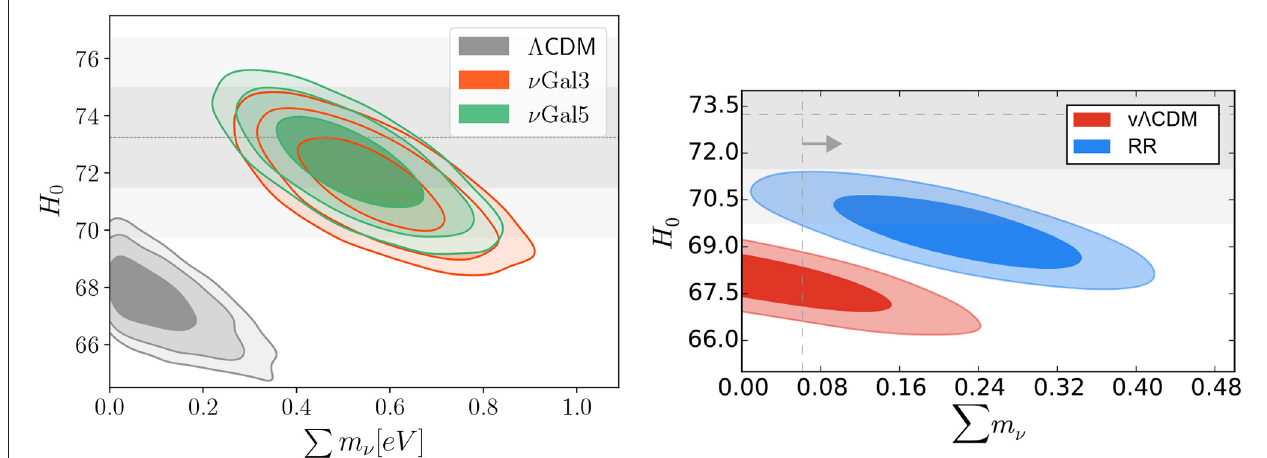
FIGURE 10 | Fit of modified gravity models to Planck + BAO, marginalized over the Hubble constant H 0 and neutrino masses and for the non-local, RR-model (Right) . A phantom-like equation of state w < non-zero neutrino mass partly compensates the effect of w , cf. Figure 4 ). Figures reproduced with permission from the authors of Renk et al. (2017) and Belgacem et al. (2018c), respectively. © SISSA Medialab Srl.. Reproduced by permission of IOP Publishing. All rights